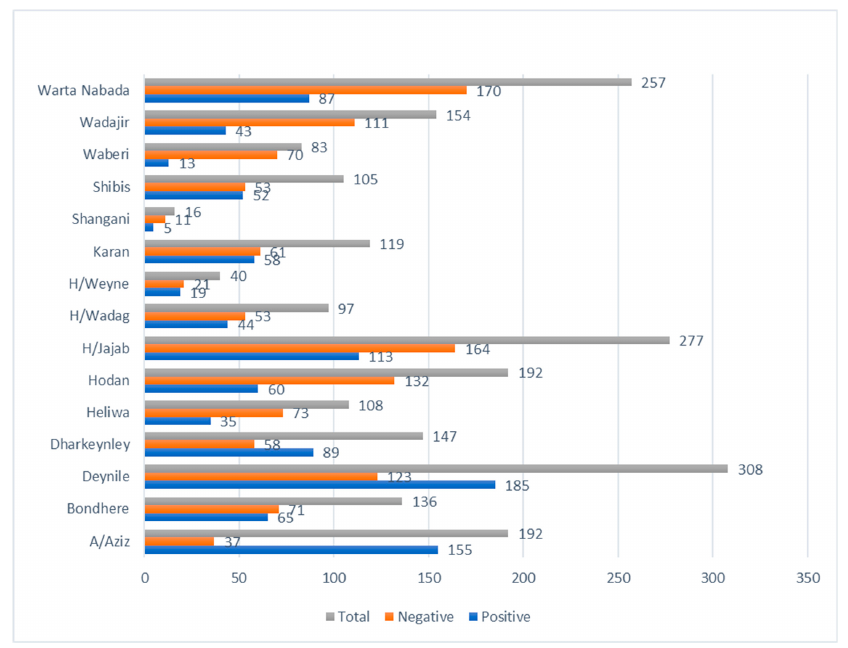
Figure 1. Seroprevalence of COVID-19 according to different districts of Benadir region, Somalia. Mogadishu cemetery: The data from the cemetery during different waves of pan- demic is presented in Figure 2. The figure clearly shows dramatic increase of number of